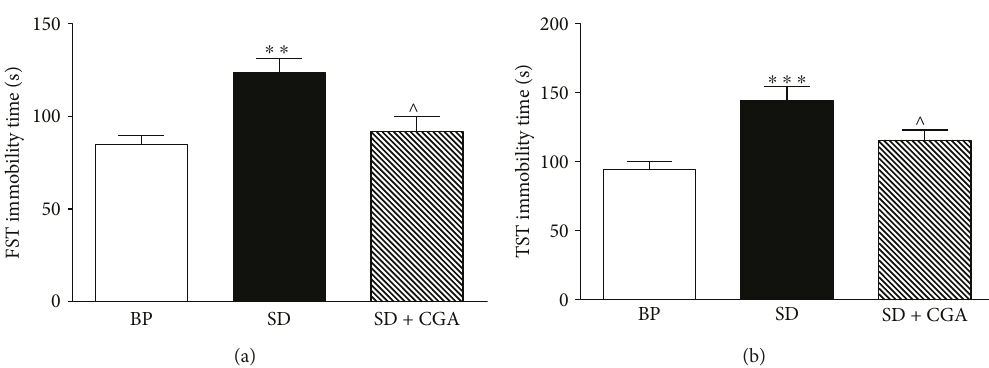
Figure 1: Behavioral test results of three groups (BP: big platform group, SD: sleep deprivation group, SD+ CGA: SD group with CGA intervention). Data are expressed as mean ± SEM ( n = 6 ). Compared with the BP group, ∗∗∗ P < 0 001 ; compared with the control group, ∗∗ P < 0 01 ; and compared with SD group, ∧ P < 0 05 .